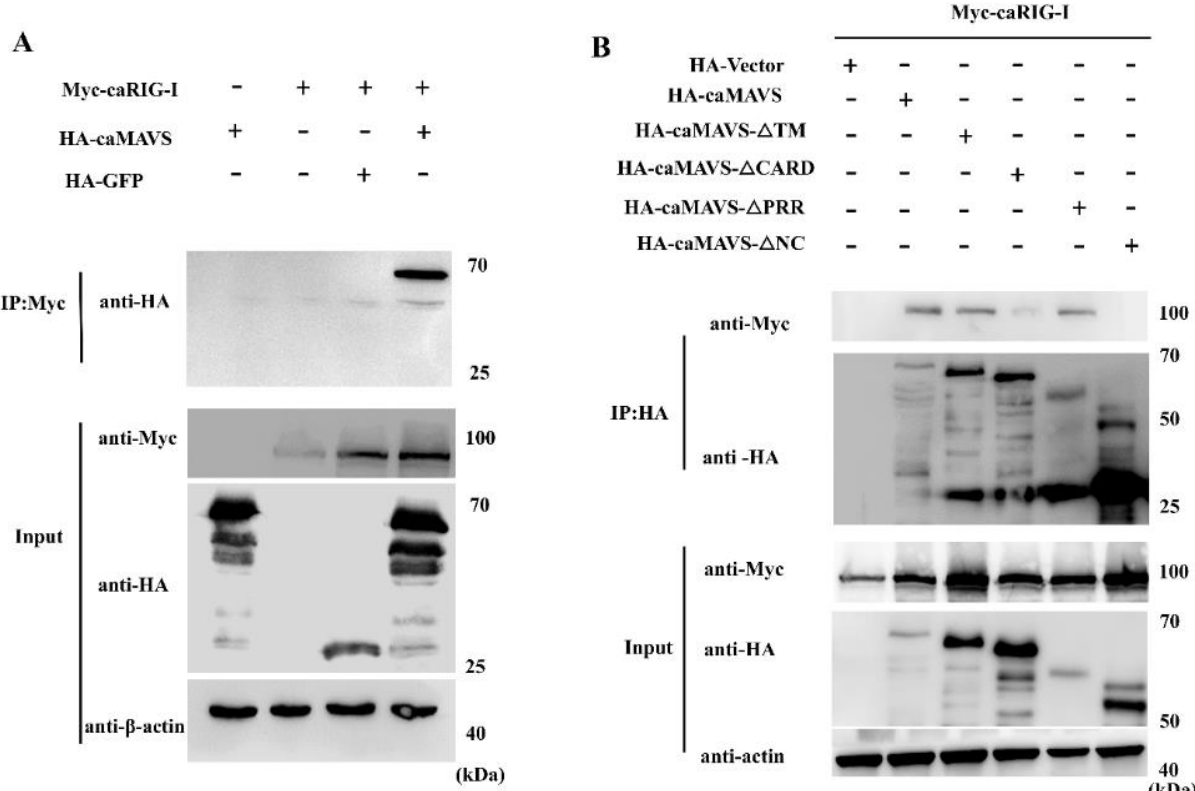
Figure 6. Identification of the interaction between caMAVS and caRIG-I by Co-IP. ( A ) HEK-293T cells seeded in 10 cm dishes and were transfected with HA-tagged MAVS or HA-GFP together with (without) Myc-RIG-I when cells were at around 60% confluency, respectively. Cells were harvested after 24 h post transfection. Cell lysates were precipitated with anti-Myc mAb resin overnight at 4 °C and precipitated proteins detected with anti-HA and anti-Myc mAbs. β-actin was used as protein loading control. ( B ) HEK-293T cells were seeded in 10 cm dishes and were transfected with HA-tagged MAVS and its mutants together with Myc-RIG-I when cells were around 60% confluency. Cells were harvested after 24 hpt and cell lysates were precipitated with anti-HA mAb resin overnight at 4 °C and precipitated proteins were detected with anti-HA and anti-Myc mAb. β-actin was used as protein loading control.